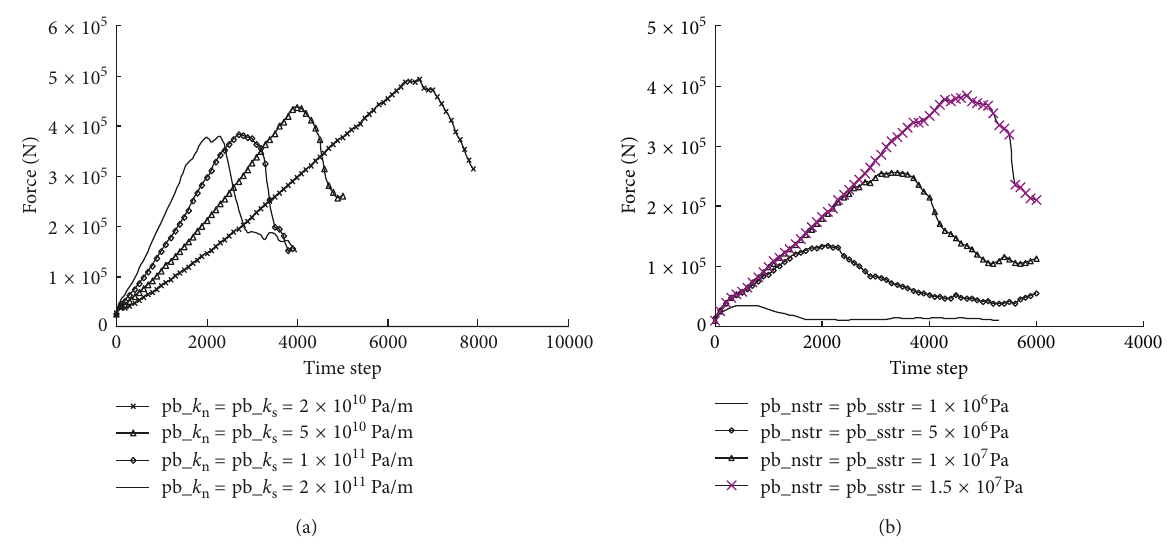
Figure 7: Influence of the parallel bond model parameters. (a) Effect of stiffness. (b) Effect of bond strength